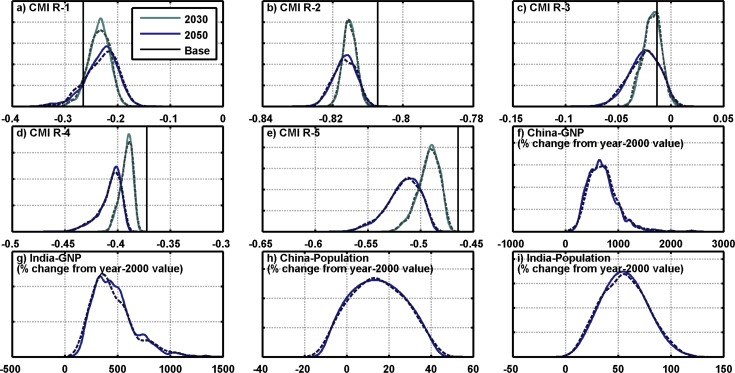
Distribution of the 14 Climate Moisture Index (CMI) statistics used in the Gaussian Quadrature thinning procedure.The solid lines show the values for the full 6,800-member ensemble. Dashed lines are the Gaussian Quadrature subset distributions for comparison. The solid vertical lines on the CMI plots (a to e) show the baseline CMI values.